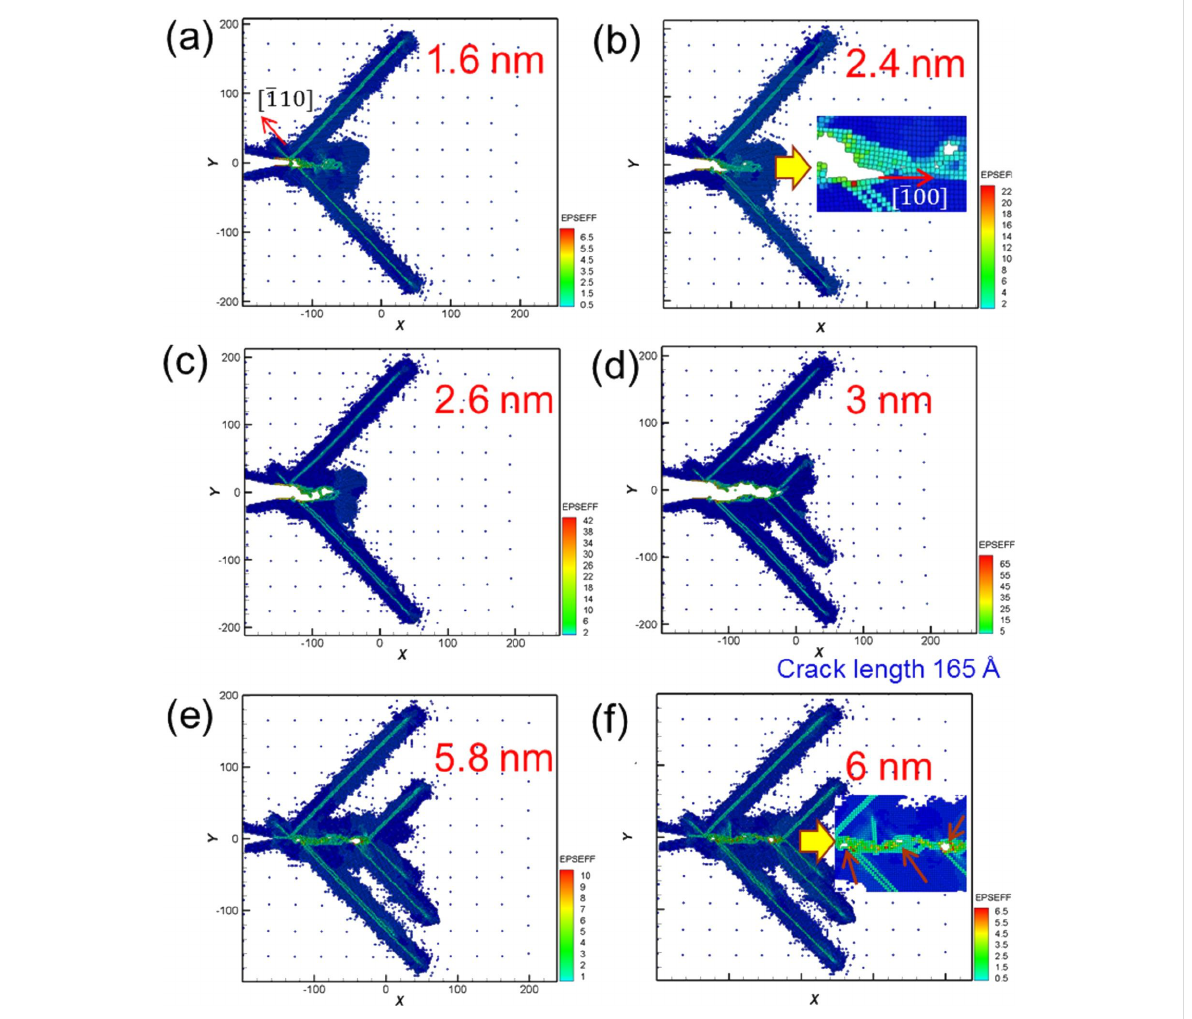
Figure 4: Crack growth and expansion diagrams of Ni during the second cyclic loading at different moving distances. The crack length is 165 Å at a tension distance of 3 nm.